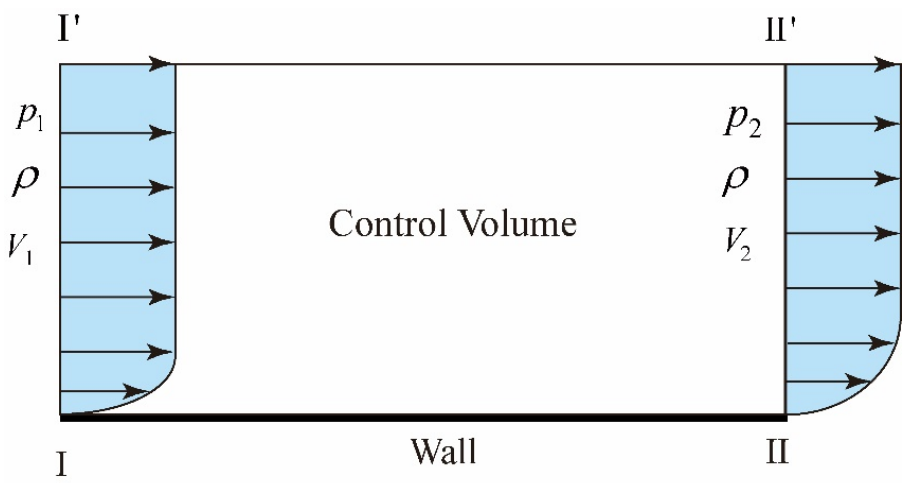
Figure 7. Schematic diagram of the control volume near the wall.